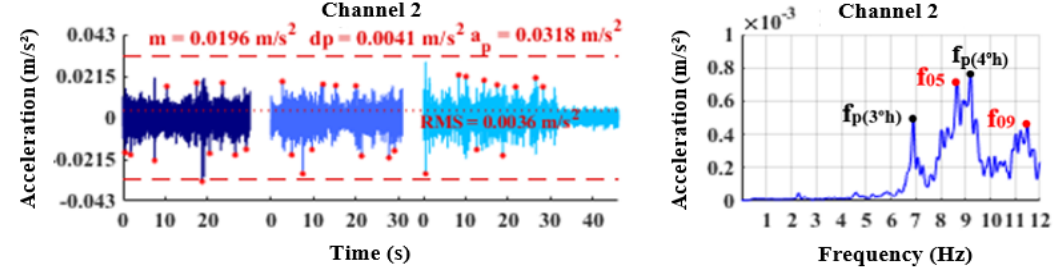
Figure 15. Dynamic response from floor 5 for fast walking on a random trajectory.